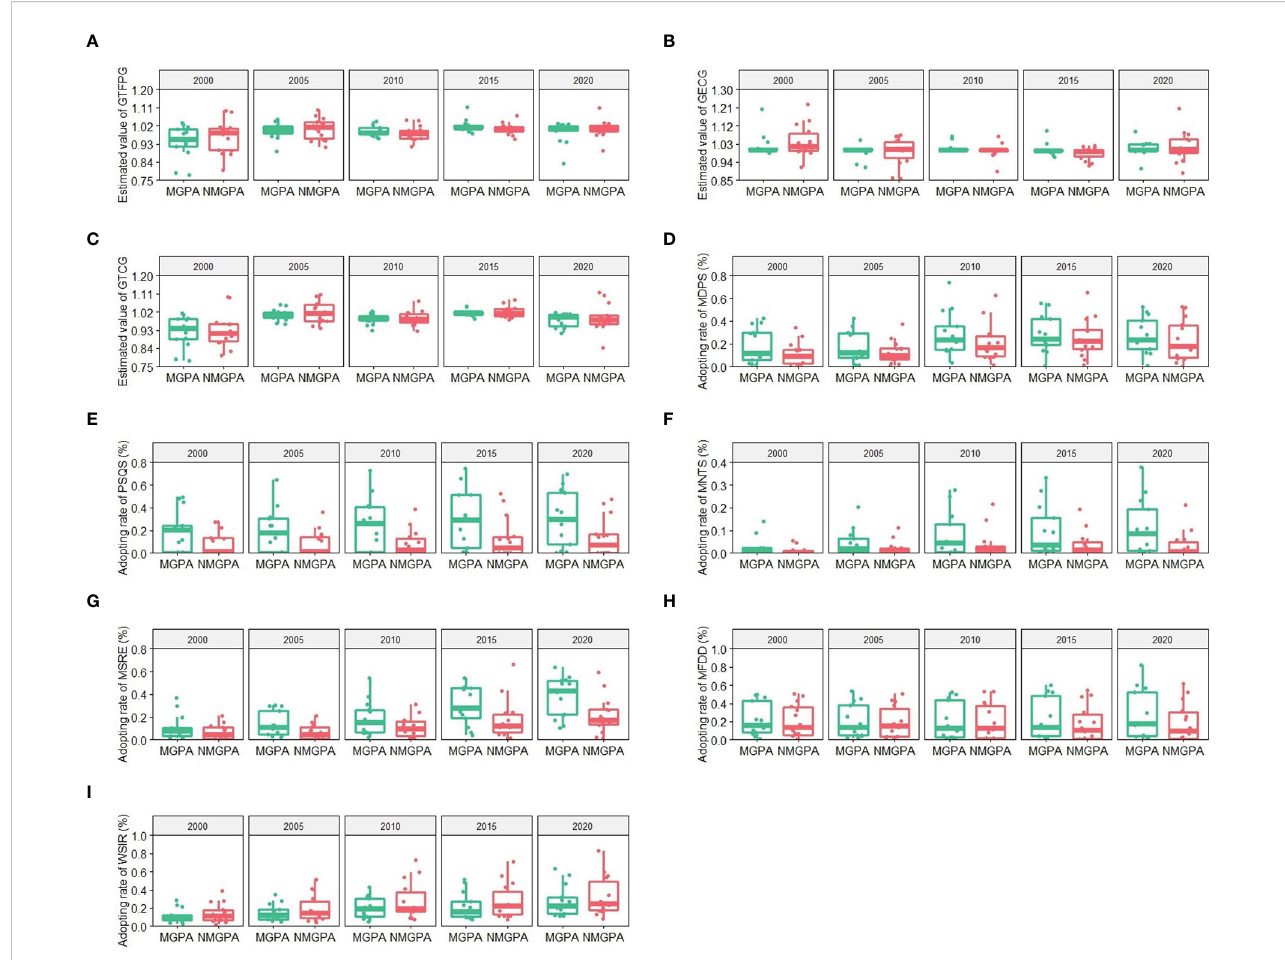
FIGURE 5 Regional difference of GTFPG, GECG, GTCG and green technologies from 2000 to 2020. MGPA: major grain producing areas; NMGPA: non-major grain producing areas. (A – C) are estimated values of GTFPG, GECG and GTCG in the major and non-major grain producing areas respectively. (D – I) are adoption rates of MDPS, PSQS, MNTS, MSRE, MFDD and WSIR in the major and non-major grain producing areas